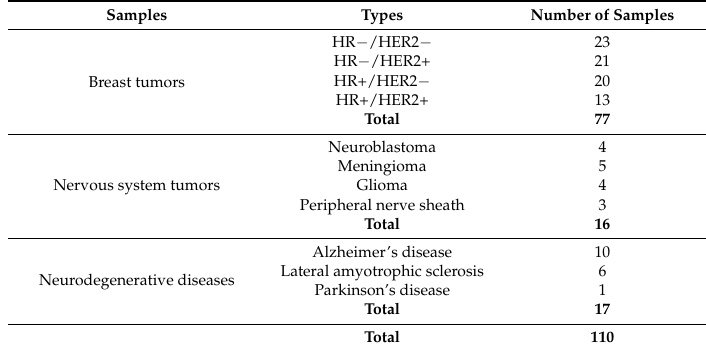
Table 1. Number and types of cancer and neurodegenerative disease samples evaluated in this study. Samples